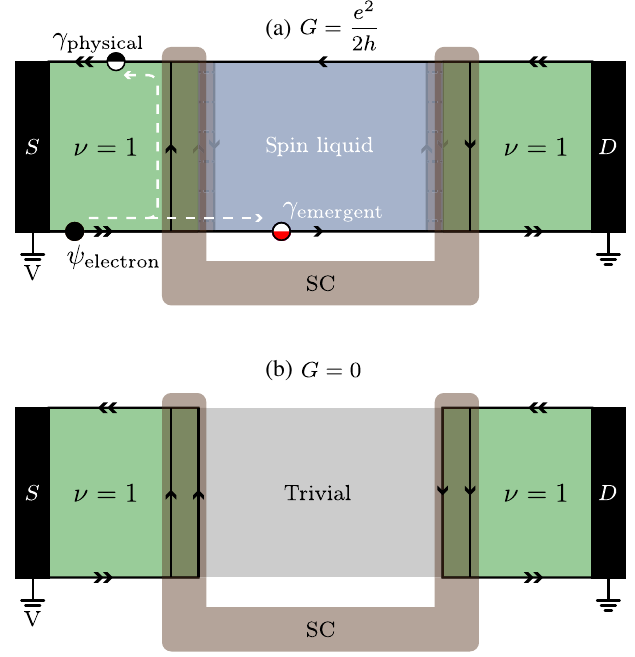
FIG. 8. (a) Circuit that electrically detects the spin liquid ’ s emergent chiral Majorana edge state. Any electrical current that flows between the source ( S ) and drain ( D ) necessarily passes through the central superconductor (and not the spin liquid). dictates the conductance — which at zero bias is quantized at G ¼ ð e 2 = 2 h Þ . (b) Control circuit in which the spin liquid is replaced with a trivial phase (e.g., a magnetically ordered state). Elimination of the physical-fermion ↔ emergent-fermion con- version processes that underlie transport in (a) leads to vanishing zero-bias conductance G ¼ 0 in this